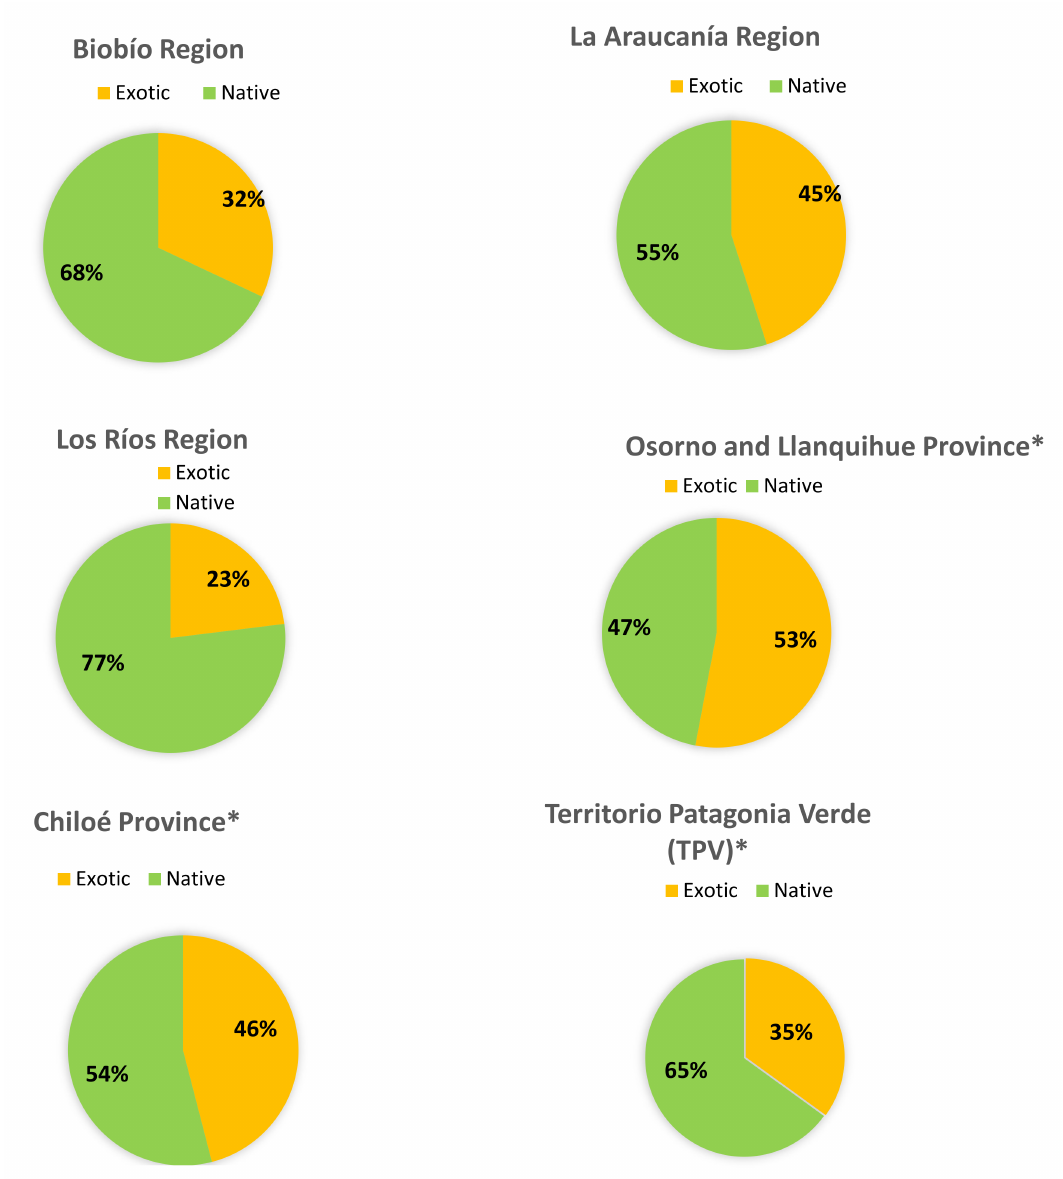
Figure 2. Distribution of native and exotic floral species found in honey samples according to the collection territory. * Territories belonging to the Los Lagos